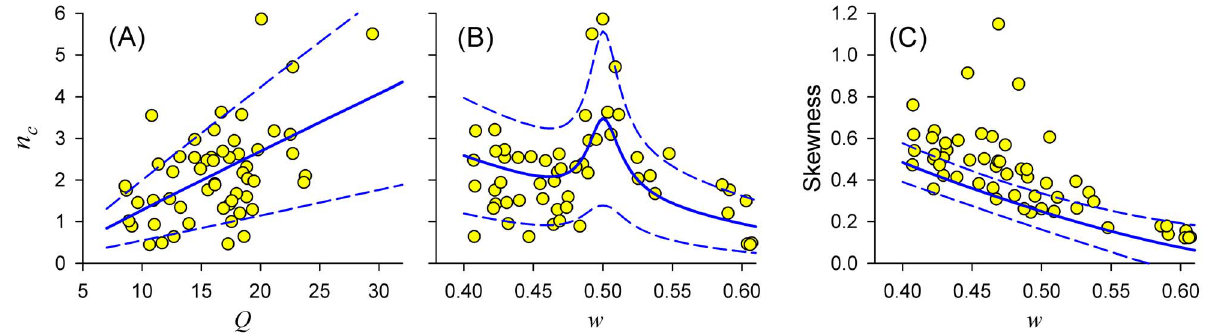
Figure 9. Statistical properties of afferent ISIs (ordinates) versus parameters of epithelial oscillations (abscissas), estimated from experimental data for the sample of n=56 paddlefish ERs (filled circles). A,B : The ISI correlation lag characteristic, n c , versus values of Q (A), or the frequency ratio w (B), of epithelial oscillations. C : Skewness of ISI distributions versus frequency ratio w . Blue lines: Theoretical results from PIF models for parameters extracted from each ER by fitting (Methods, final section), while varying Q or w . Solid blue lines: Mean curves for the sample. Dashed blue lines: + 1 standard deviation.